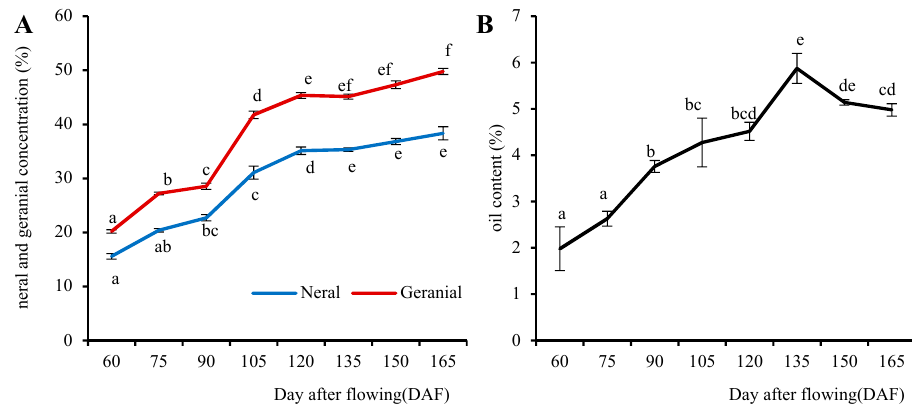
Figure 1. Changes in the concentration of citral and oil content at different developmental stages in L. cubeba. Citral concentration ( A ) and oil content ( B ) were measured during the fruit development. The means ± SE are given. The different lower case letters (a–f) indicate significant differences p < 0.05). Identical letters indicate the absence of a significant difference and different letters indicate a significant difference.